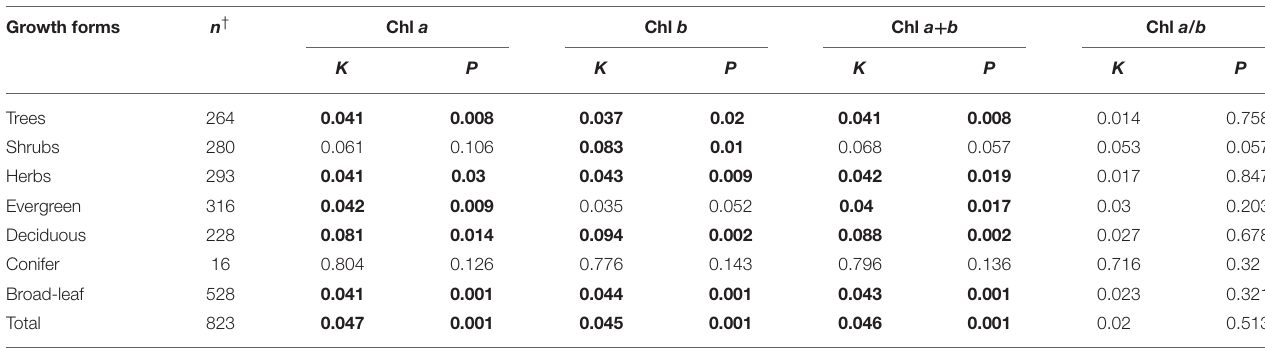
TABLE 4 | Strength of the phylogenetic signal in chlorophyll traits for different growth forms. Growth